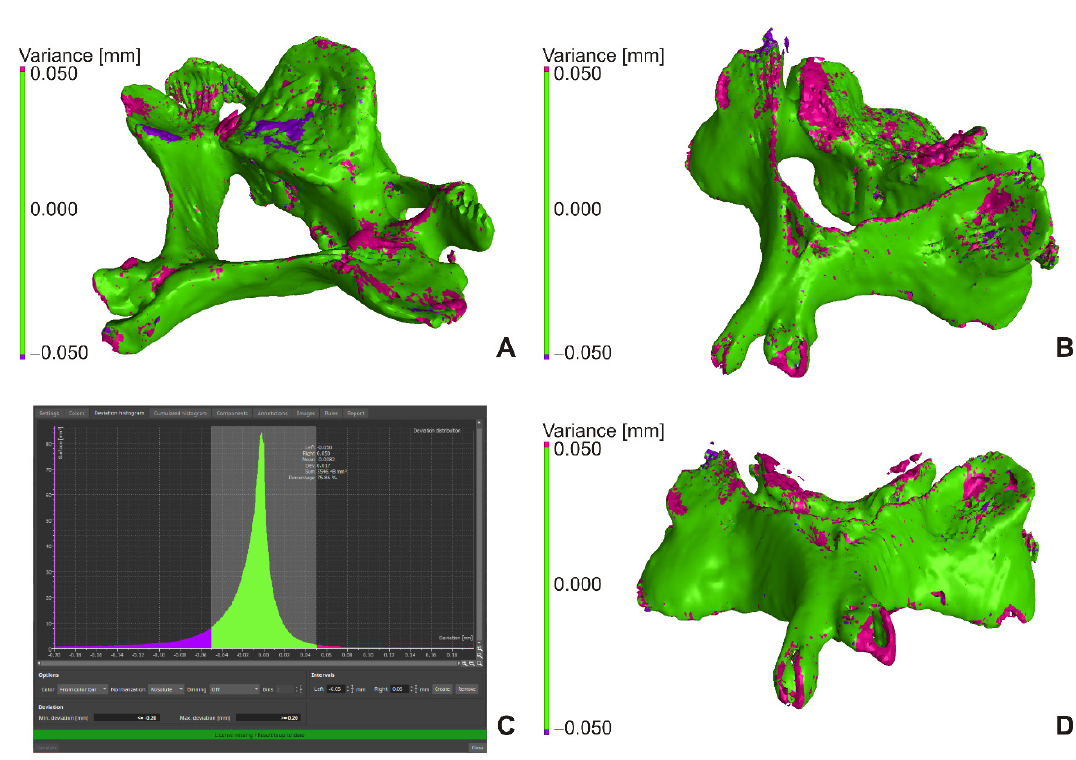
Figure 4. VG2 to VG1 comparison ( A , B ), histogram for VG2 to VG1 comparison ( C ), VG3 to VG2 comparison ( D ). Mimics